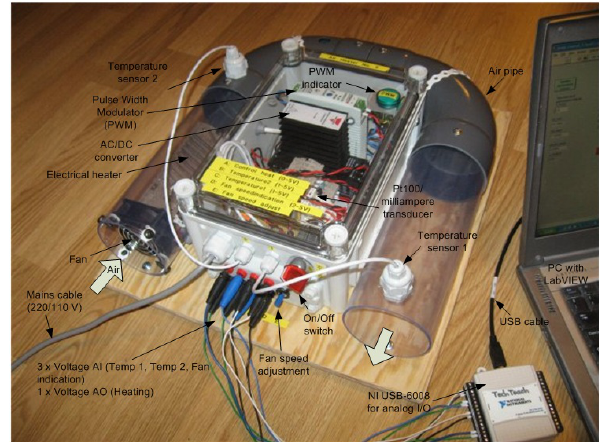
Figure 1: The air heater lab station with NI USB-6008 analog I/O device.